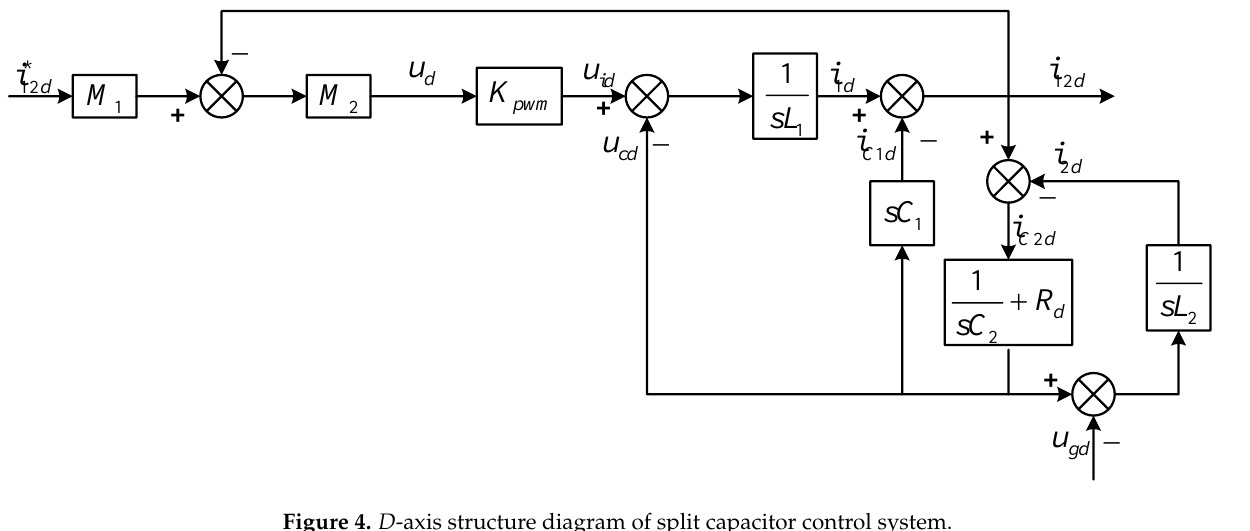
disturbance of the system. The performance of the first-order LESO will affect the